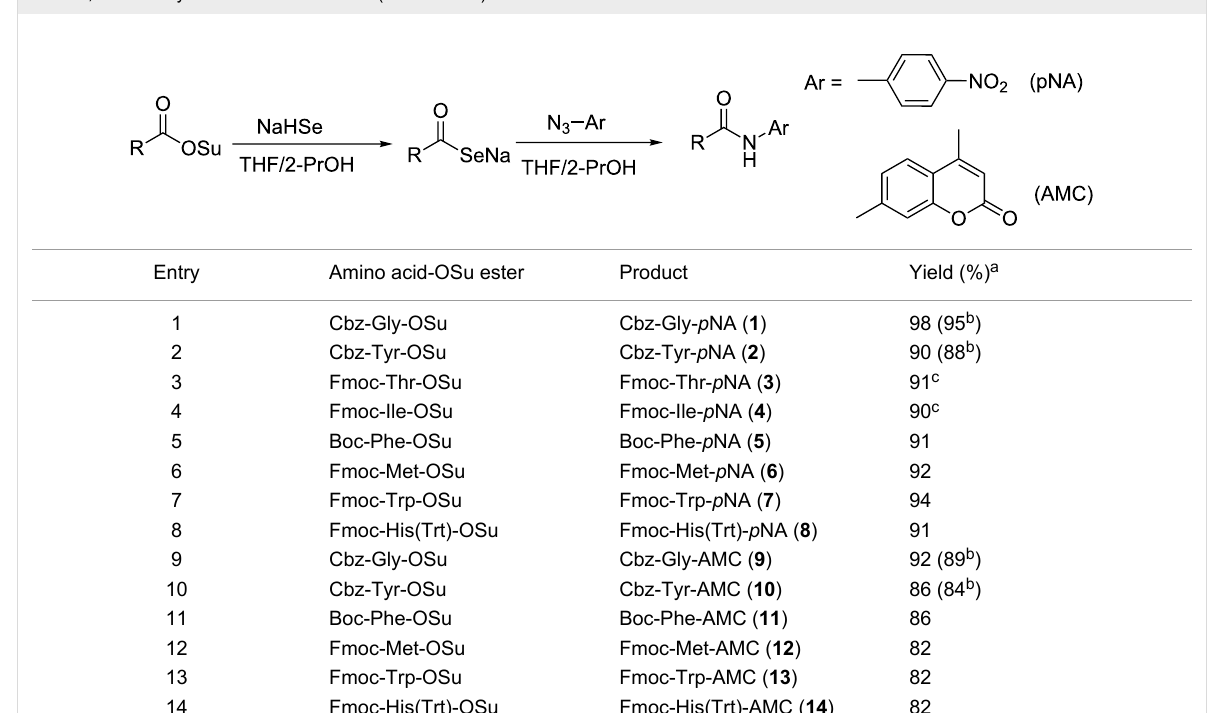
Table 1: Synthesis of N α -protected aminoacyl- p NAs and aminoacyl-AMCs through selenocarboxylation of N α -protected amino acid OSu esters with NaHSe, followed by reaction with the azides (Procedure